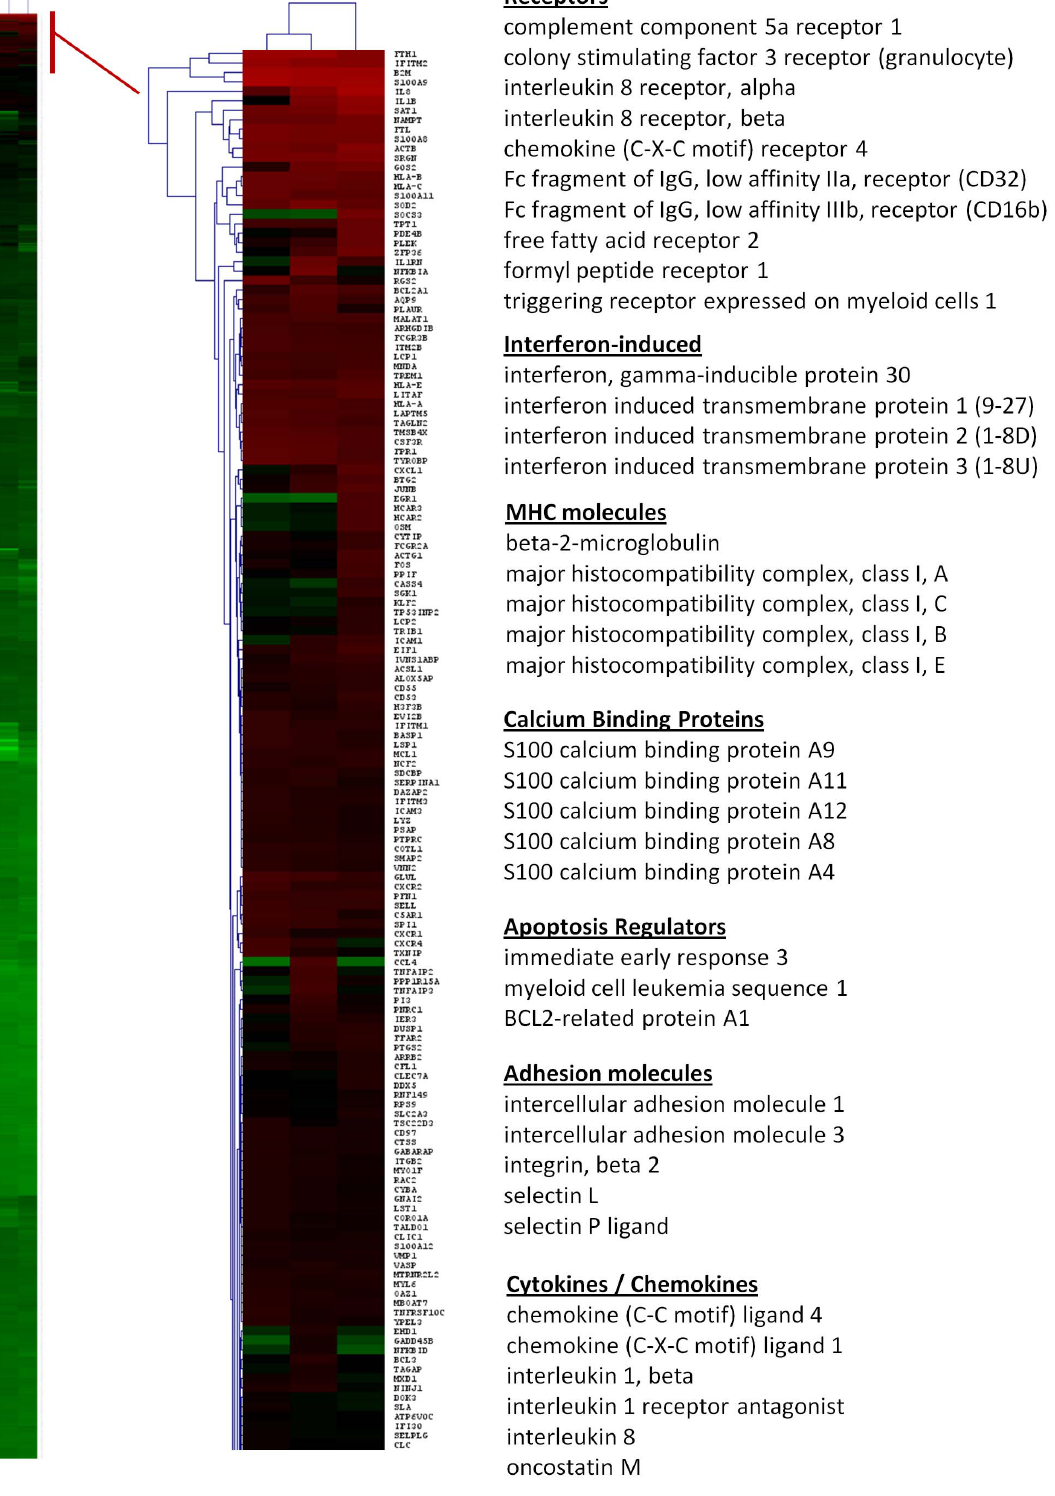
Figure 4. Hierarchical cluster analysis of genes expressed (RPKM $ 10) in untreated and cytokine treated neutrophils. RPKM values are represented on a log 10 scale, where green is low expression and red is high expression. An expanded heat map of highly expressed genes (red bar) is also shown. These highly-expressed transcripts include genes that can be categorised as cytokines/chemokines, cell-surface receptors, interferon-induced genes, Major Histocompatibility Complex (MHC) proteins, calcium binding proteins, apoptosis regulators and adhesion molecules.